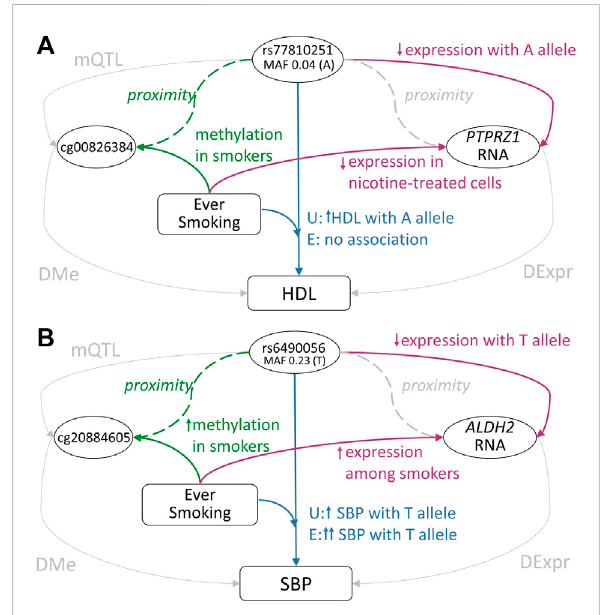
FIGURE 4 Summary of evidence for two GLI loci (see text for further details). Pathways without evidence for the association have been grayed out (A) PTPRZ1 GLI Locus: the GLI variant rs77810251 in PTPRZ1 is also an eQTL with downregulated expression in aortic tissue, and was in close proximity to the DNAm site cg00826384, which shows elevated methylation among smokers (B) ALDH2 GLI Locus: the GLI variant rs6490056 in ALDH2 is also an eQTL with downregulated expression in multiple tissues and was in close proximity to the DNAm site cg20884605, which shows elevated methylation among smokers. U: unexposed individuals, E: exposed